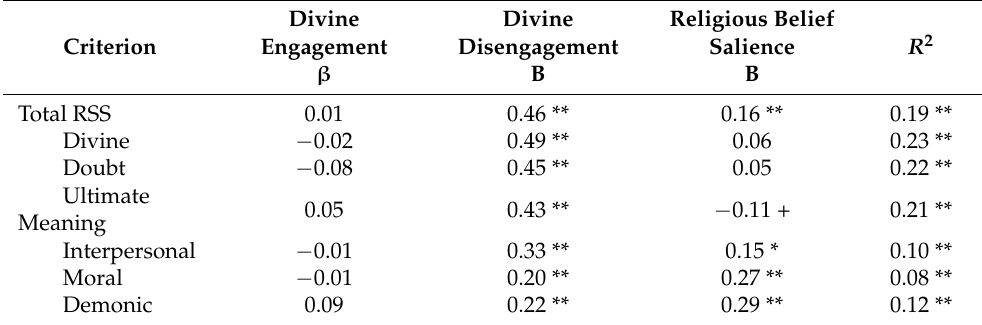
Table 8. Simultaneous Regressions Predicting Religious/Spiritual Struggles from Divine Engagement, Disengagement, and Religious Belief